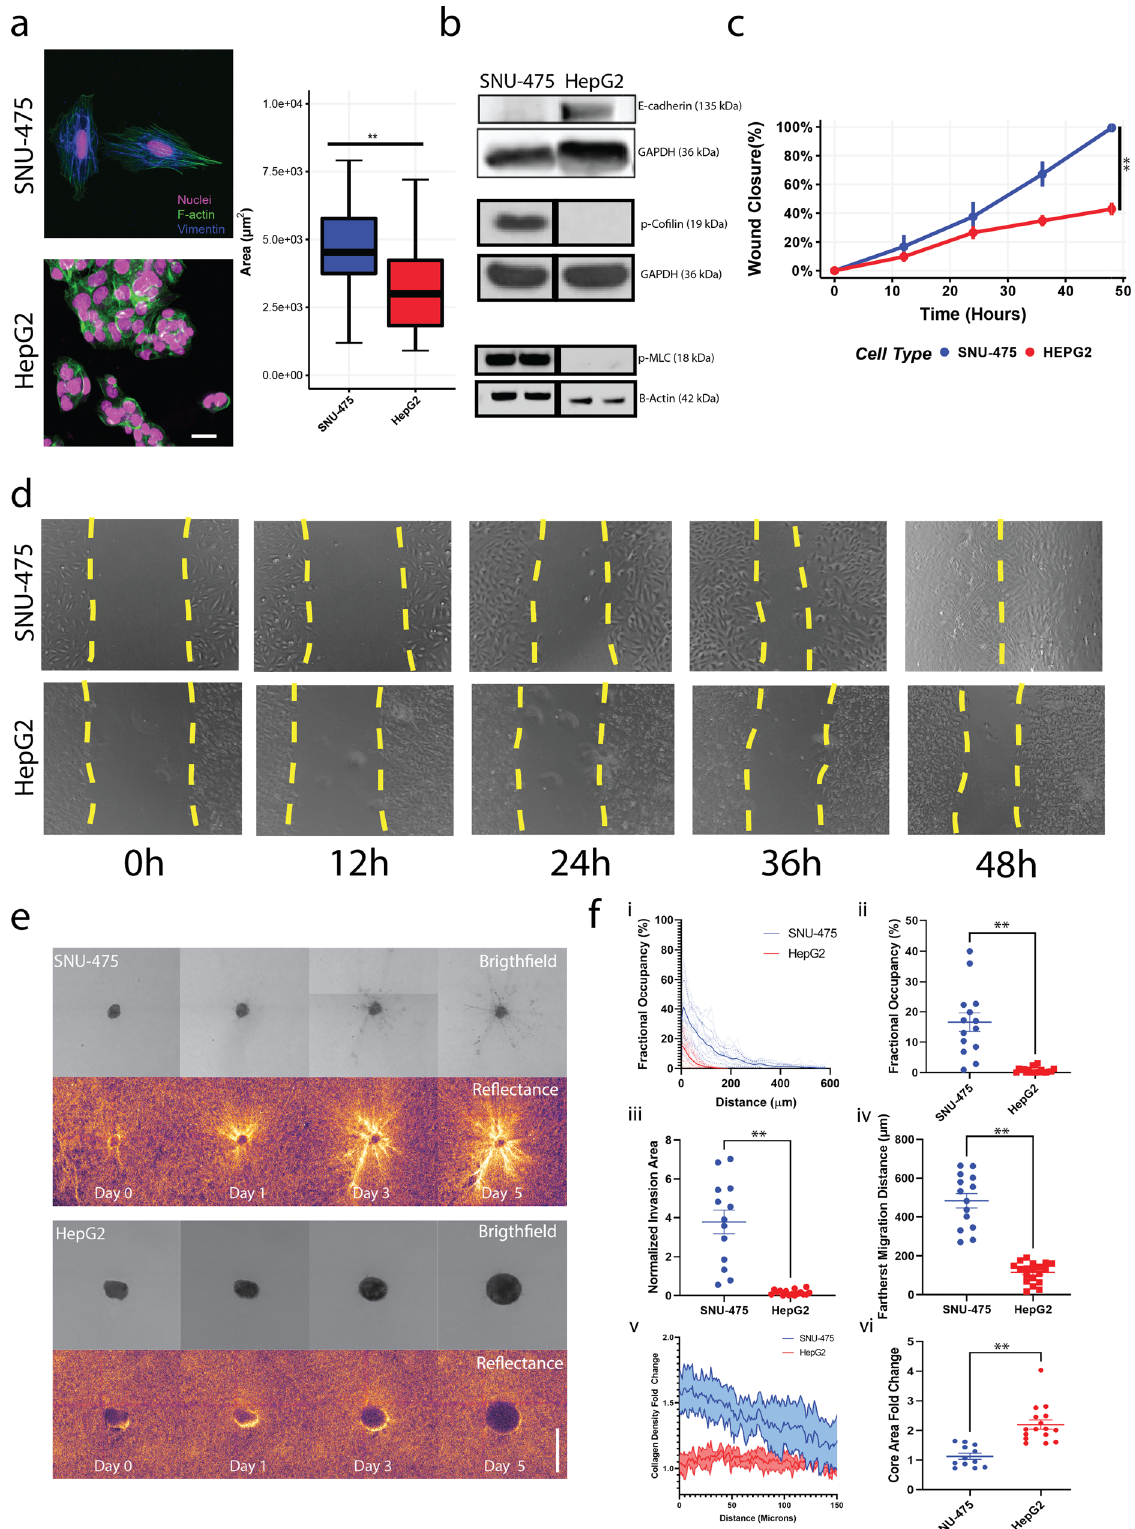
increase cell circularity and decrease HepG2 cell spreading (Fig. 3d, ii). Although LIMK1 appeared to inhibit HepG2 wound closure rate, it did not affect HepG2 nuclear or cellular morphology. Interestingly, PAK4 inhibition caused HepG2 cells to have increased solidity (Fig. 3d, ii). This was a result of the decrease in the spread area as well as a decrease in